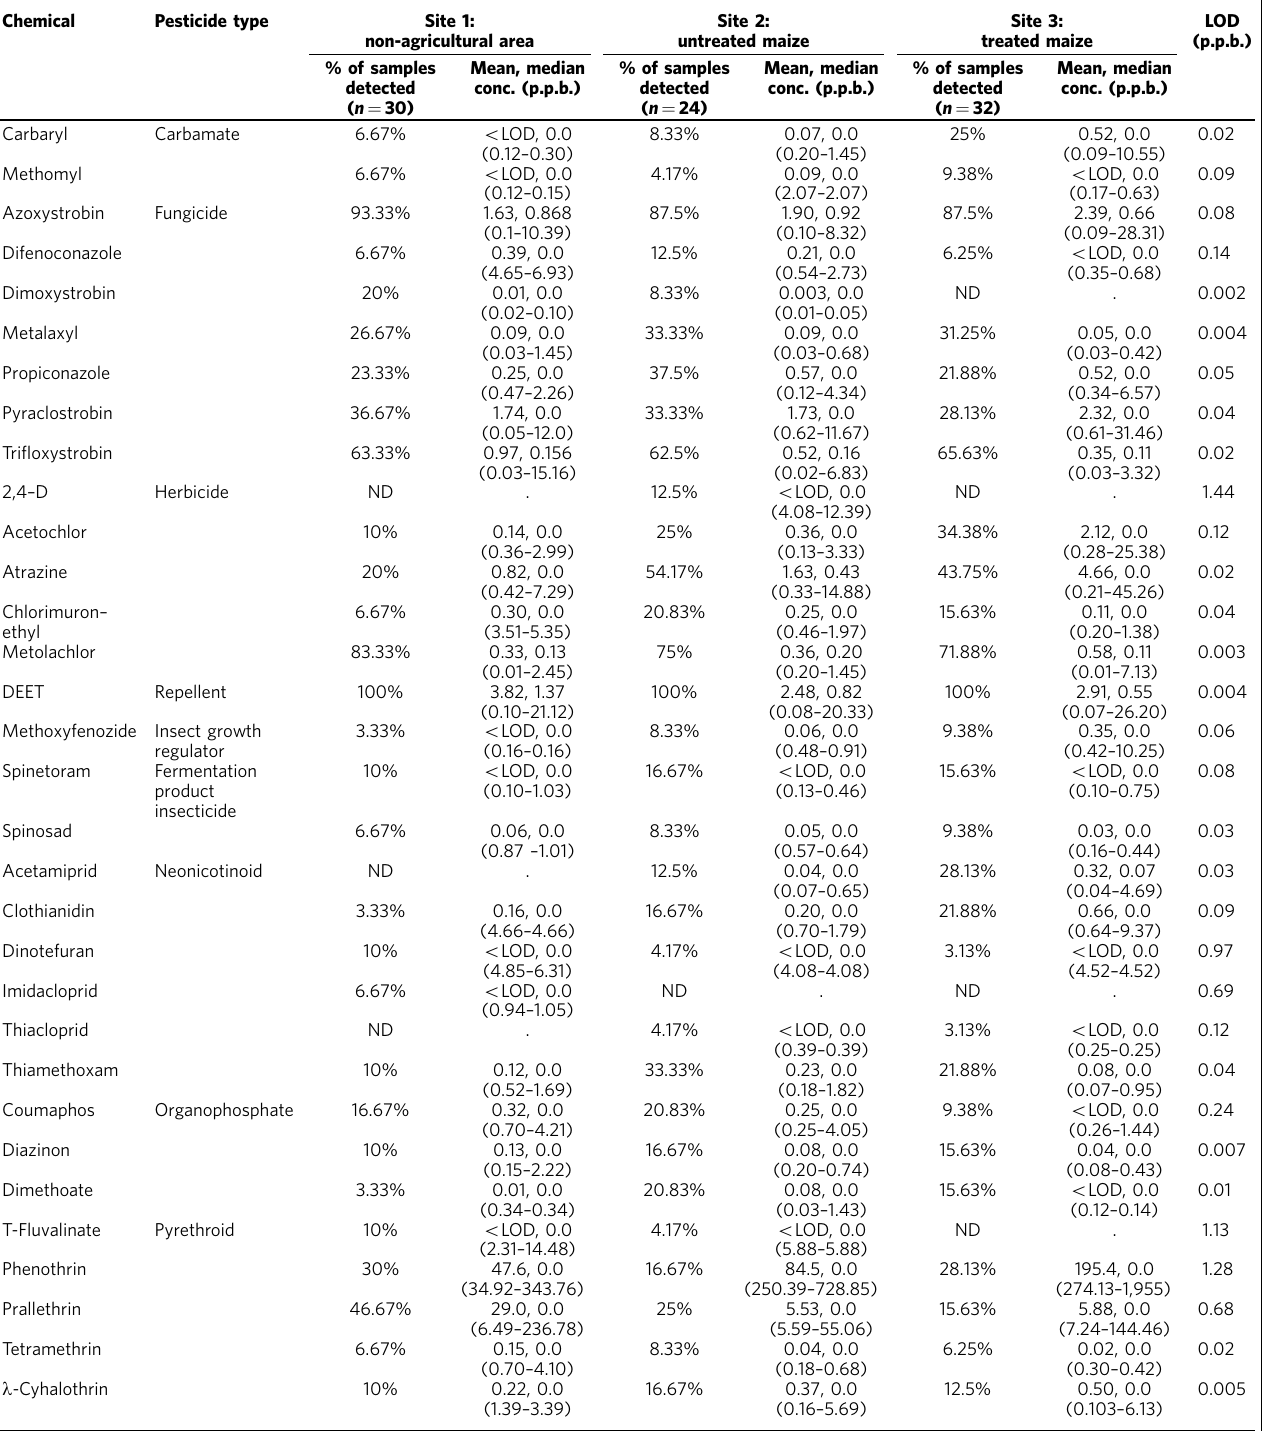
Table 1 | The mean, median and range of concentrations for 32 pesticide active ingredients detected in pollen samples collected from honey bee colonies over a 16-week